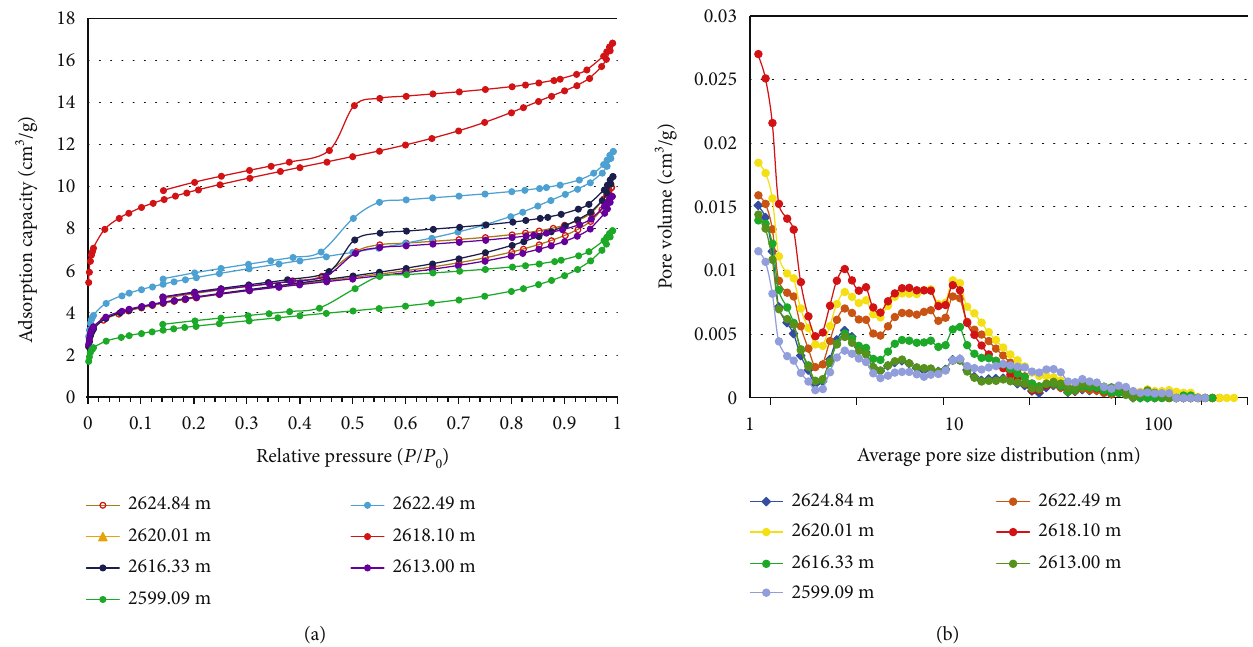
Figure 8: Nitrogen adsorption isotherm (a) and pore size distribution diagram (b) of black shale in well ZY1 in southeast Chongqing. Table 2: Pore structure parameter statistics of black shale in Wufeng-Longmaxi Formation of well ZY1 in southeast Chongqing.